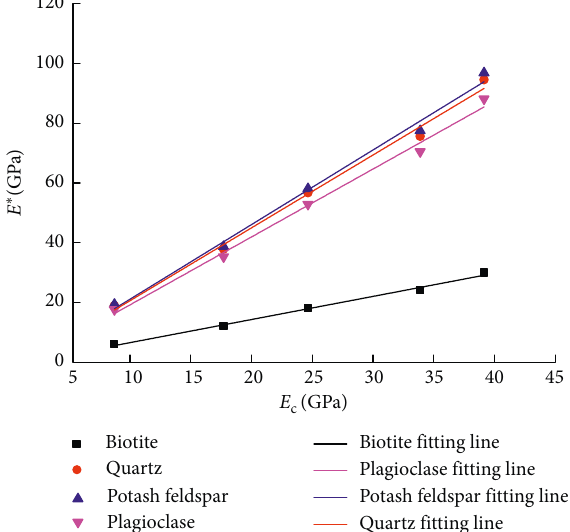
Figure 9: Relationships between the compressive Young’s modulus and particle contact Young’s modulus of different